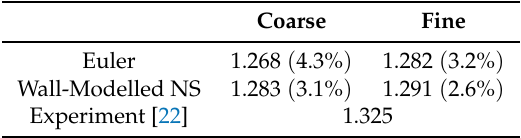
Table 2. Drag coefficient and its difference from the experiment (%).